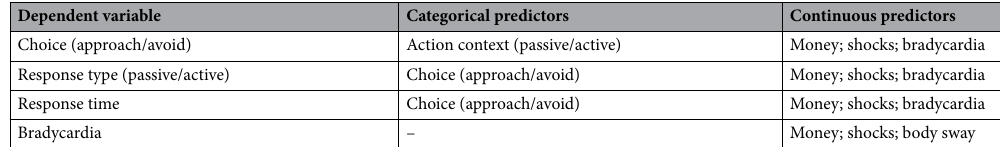
Table 2. Model specifications of mixed models to test task effects on choice behavior and psychophysiology. Note . Money and shock amounts ranged 1 –